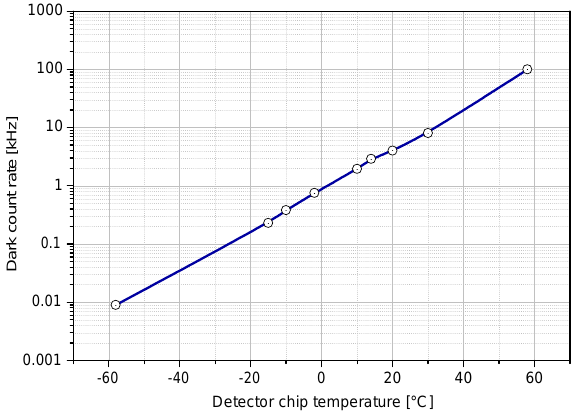
Figure 7. Dark count rate of the detector is strongly dependent on temperature of the structure. Depicted dependence is valid for typical K14 SPAD of 40 µm active area operated 0.7 V above breakdown voltage. Note the slope of one decade decrease of dark count rate per 30 K. The absolute value of dark count rate depends on bias, see Figure 8.